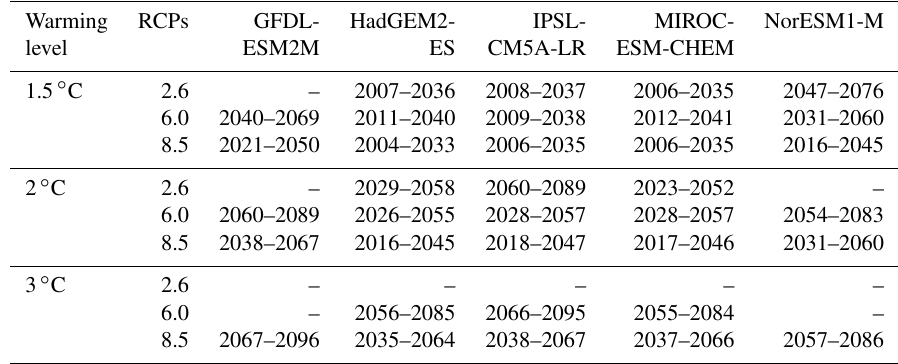
Table 1. Time periods of 1.5, 2, and 3 ◦ C global warming in five GCMs under three RCPs. Warming RCPs GFDL- HadGEM2- IPSL- MIROC- NorESM1-M level ESM2M ES CM5A-LR